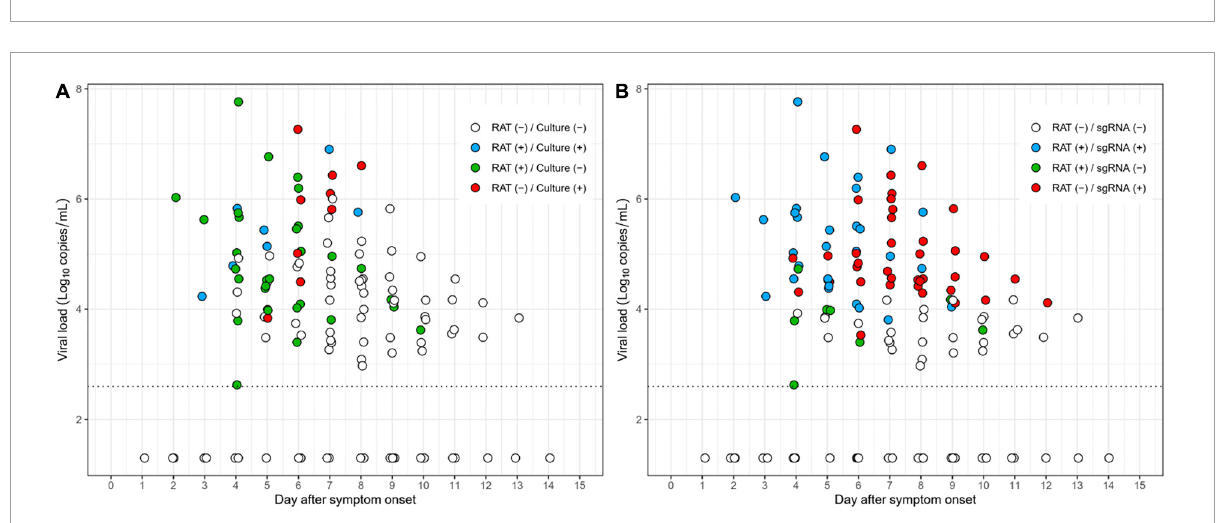
FIGURE2 Density plots of positive and negative results for each test. (A) Density plot for positive results by test. (B) Raincloud plot for positive results by each test. (C) Density plot for negative results by test. (D) Raincloud plot for negative results by each test. sgRNA, subgenomic RNA; gRNA, genomic